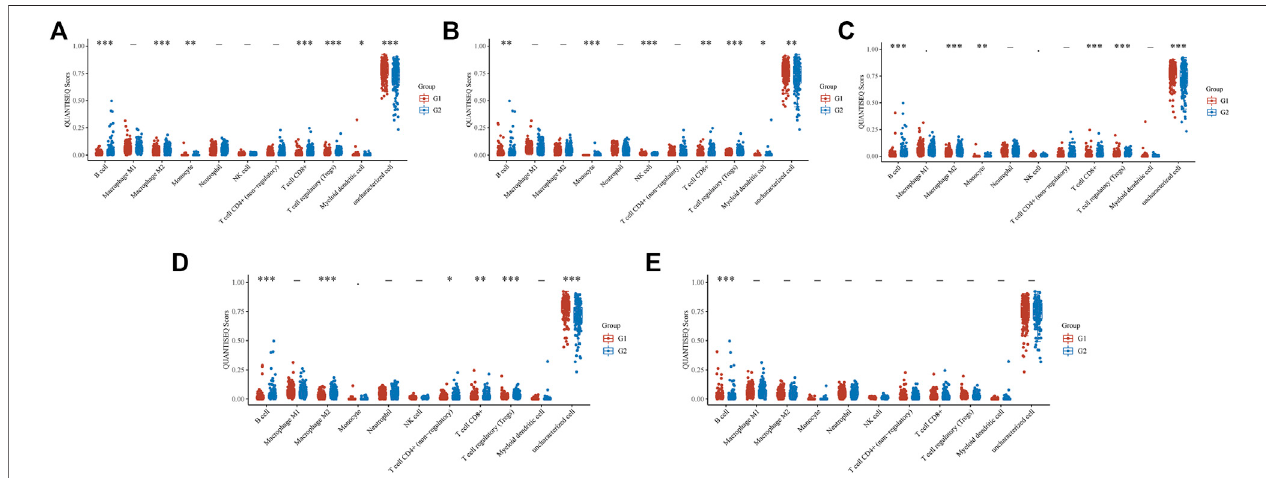
FIGURE 6 | The QUANTISEQ Score distribution of immune cells at different EFNA gene expressions. (A) EFNA1 , (B) EFNA2 , (C) EFNA3 , (D) EFNA4 , and (E) EFNA5 . The horizontal axis represents different immune cells, the vertical axis represents the gene expression distribution, and the different colors represent different groups. Asterisks represent levels of signi fi cance (* p < 0.05, ** p < 0.01, *** p < 0.001).